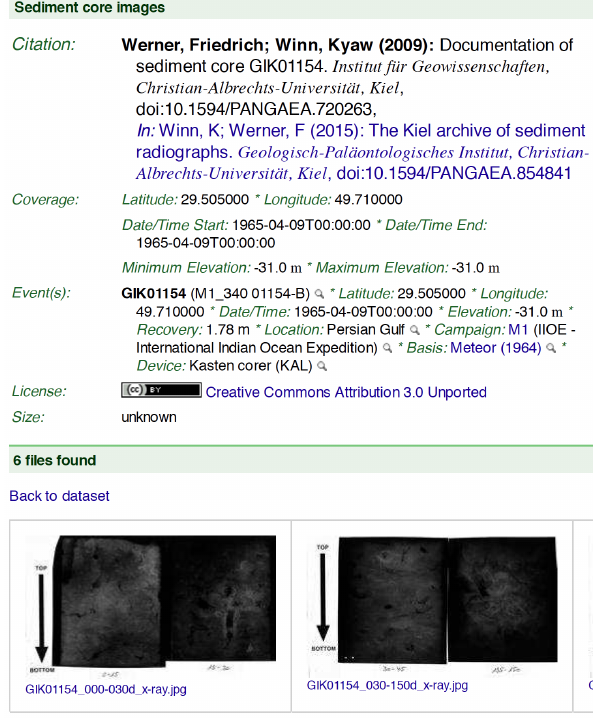
Figure 8. Example of the standard metadata header provided by PANGAEA from dataset https://doi.org/10.1594/PANGAEA. 720263. Starting with the citation, comprising author(s), year, ti- tle, source and DOI. Citation is followed by the georeference in space and time and links to further references or reports. For this collection, images of each core location have their own data subset. The total of 1355 data subsets of this paper are grouped together in one “parent” dataset (https://doi.org/10.1594/PANGAEA.854841). At the end of the metadata header, each image is shown as a thumb- nail and can be downloaded either individually or as part of a com- pilation of all images in a single zip